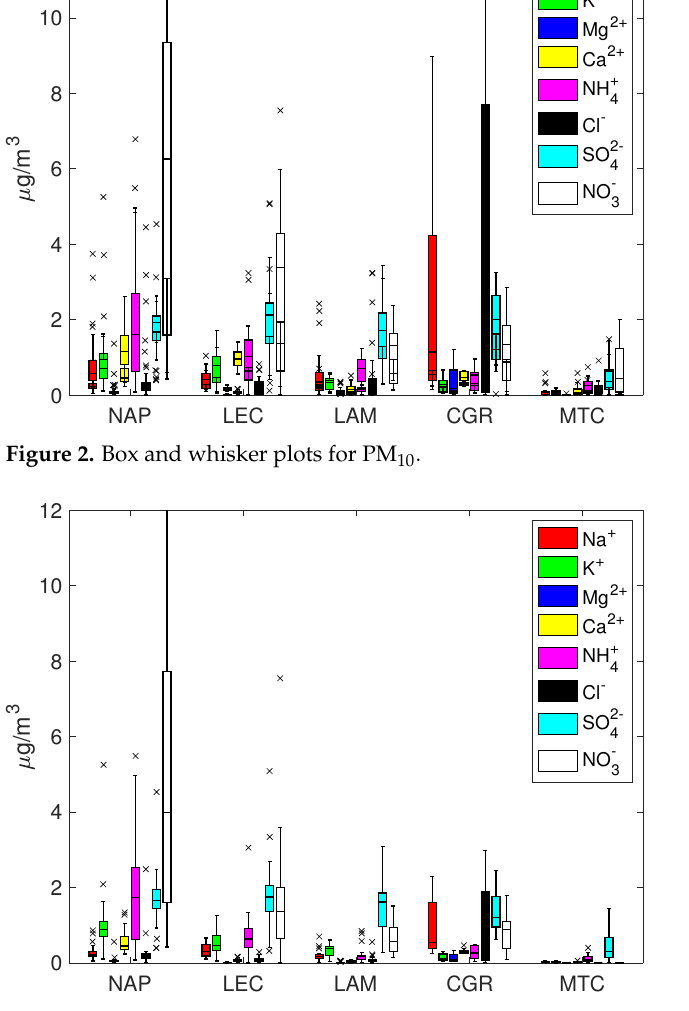
Figure 3. Box and whisker plots for PM 2.5